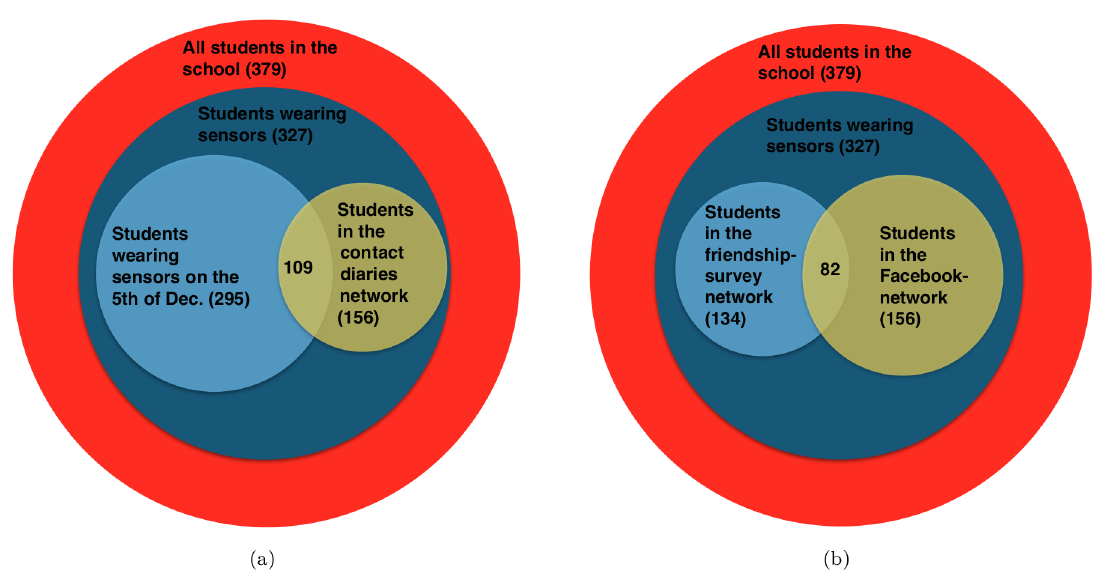
Fig 2. Venn diagrams representing the sets of students concerned by the various data collection